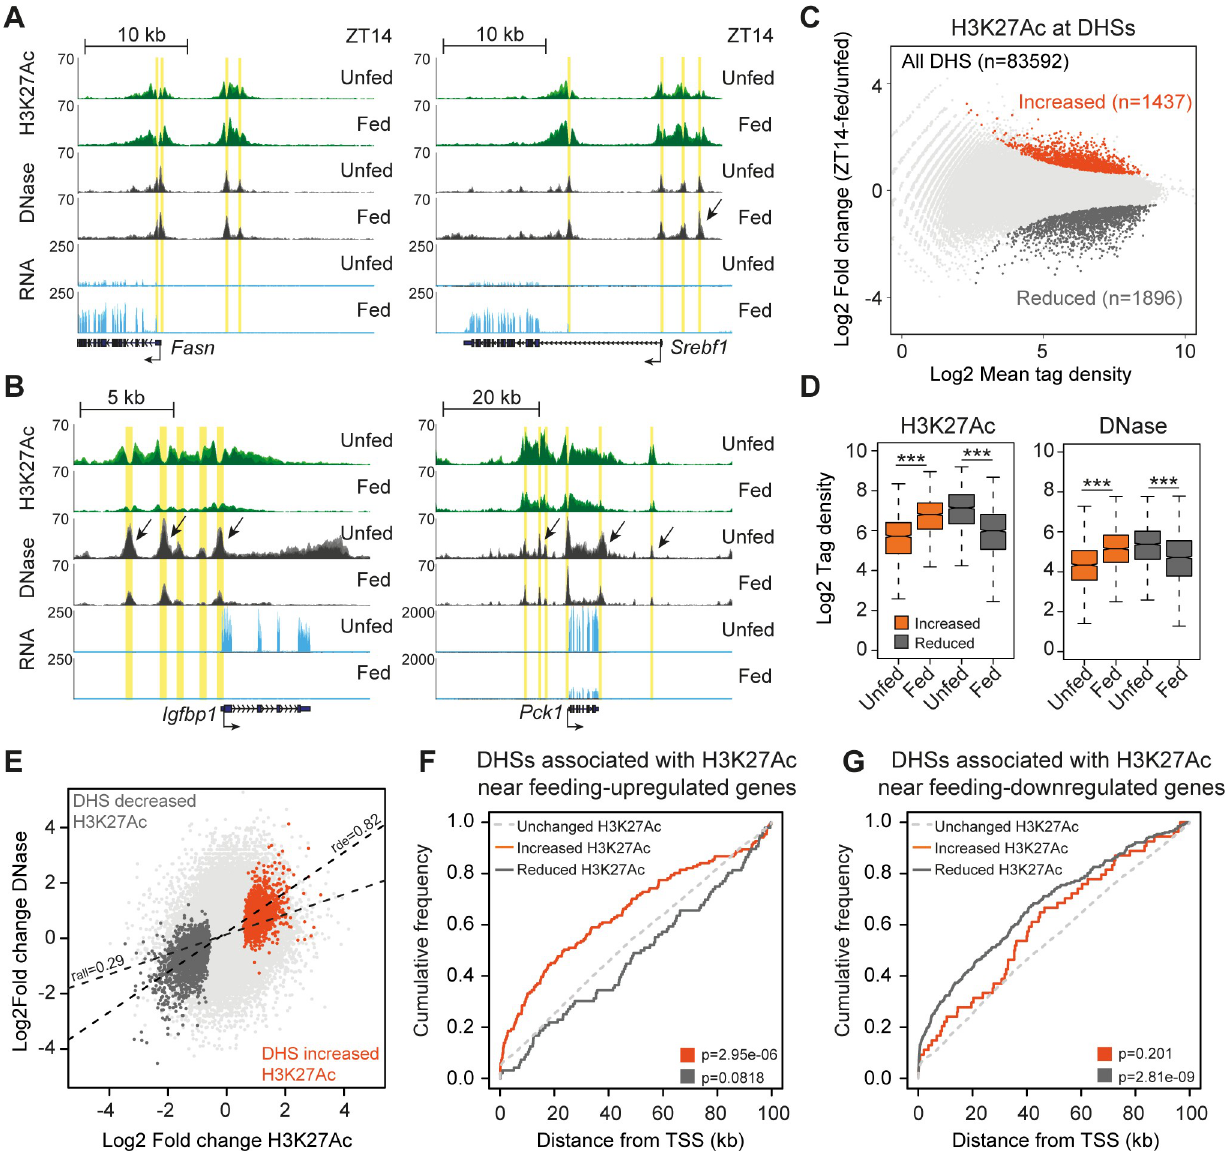
Fig 2. Postprandial DNase accessibility and H3K27 acetylation. RNA-seq, DNase-seq, and H3K27Ac ChIP-seq from livers of mice euthanized at ZT14-unfed and ZT14-fed. (A and B) Fasn , Srebf1 , Igfbp1 , and Pck1 mRNA expression and nearby DNase accessibility and H3K27Ac. Yellow regions mark DNase-accessible regions associated with differentially regulated H3K27Ac. Arrows mark differentially regulated DNase accessibility. (C) Differential H3K27Ac at DHSs. Increased H3K27Ac is marked by red, and decreased H3K27Ac is marked by dark gray, FDR < 0.1 ( n = 3). (D) Tag density of H3K27Ac ChIP-seq and DNase-seq at DHSs associated with feeding-regulated H3K27Ac. Statistical significance is calculated using a Mann– Whitney–Wilcoxon test. ��� p > 0.001. (E) Correlation between differentially regulated DNase accessibility and H3K27Ac. Regression analysis is calculated for the differentially regulated DHSs (r de ) and all DHSs (r all ) using Pearson correlation. (F) Cumulative distribution of DHSs associated with feeding- regulated H3K27Ac near TSSs of feeding–up-regulated genes. (G) Cumulative distribution of DHSs associated with feeding-regulated H3K27Ac near TSS of feeding–down-regulated genes. A Kolmogorov–Smirnov test was applied to test for differential distribution of DHSs associated with feeding-regulated H3K27Ac (gray and orange line) compared to DHSs associated with no change of H3K27Ac (broken line). Numerical values for panels C–G are available in S2 Data. Bed graphs in panels A and B are available at GEO: GSE119713. ChIP, chromatin immunoprecipitation; DHS, DNase hypersensitive site; FDR, false discovery rate; H3K27Ac, Histone 3 lysine 27 acetylation; TSS, transcription start site.